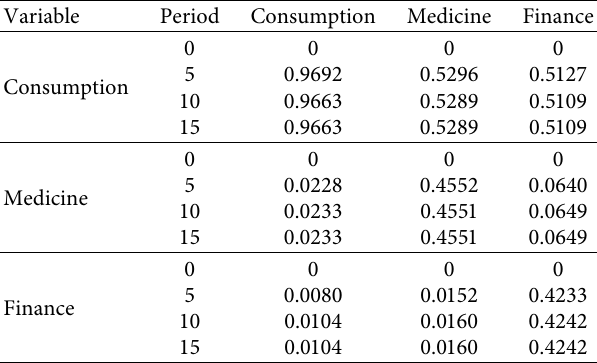
Table 5: Variance decompositions of the consumption industry, pharmaceutical industry, and fnancial